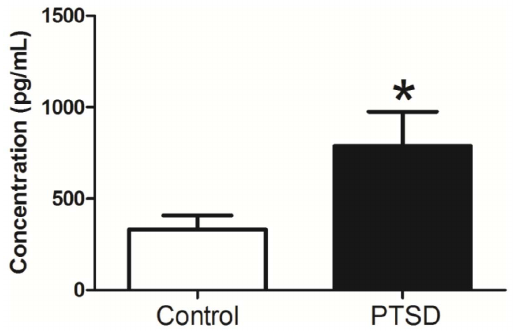
Figure 2. Post-stress corticosterone levels. After 31 days of the predator exposure/psychosocial stress regimen, plasma corticosterone levels were higher in the PTSD group. Corticosterone was measured in plasma collected at the time of sacrifice and frozen prior to testing. Data are presented as 6 SEM. *p , 0.05 relative to the control